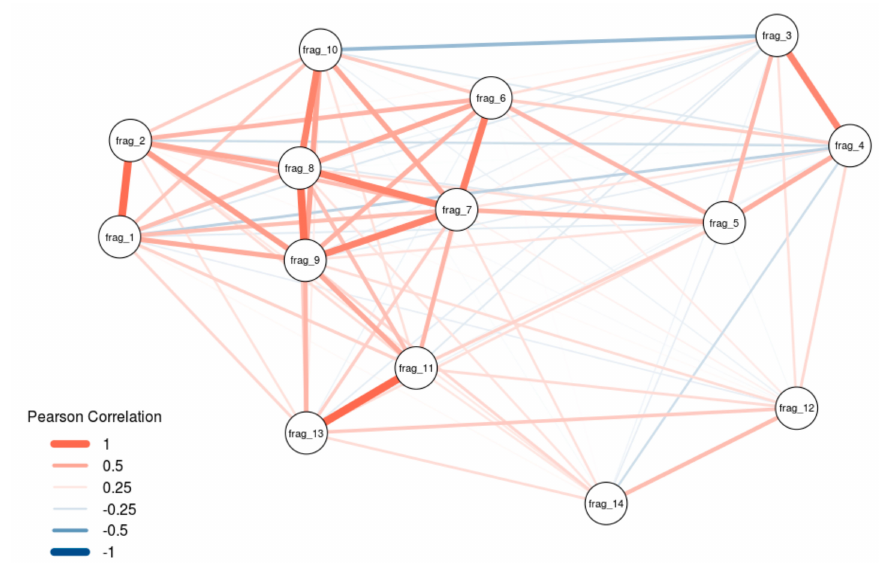
Figure 4. Weighted network diagram describing the resemblance of binding patterns of the di ff erent RNA fragments. Nodes represent RNA fragments. Thickness and length of edges connecting nodes correspond to the pairwise Pearson correlation coe ffi cient between the protein enrichments of two RNA fragments. Red and blue colors correspond to positive and negative correlations,